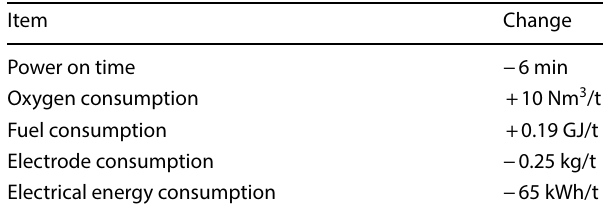
Table 2 Jet-box system analysis at ISCOR [12]